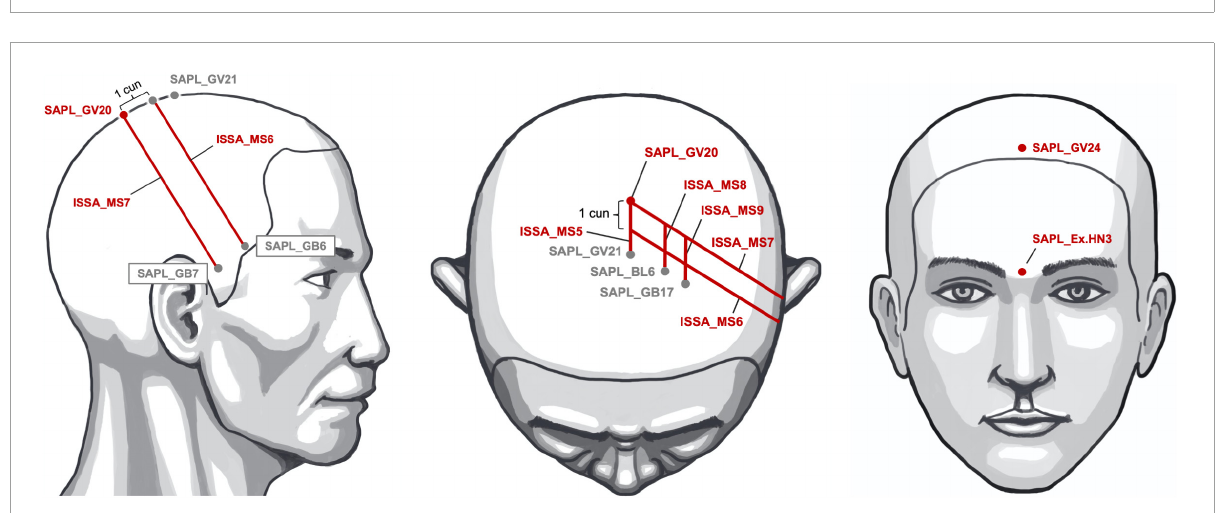
FIGURE5 Grouped matrix for 15 association rules.